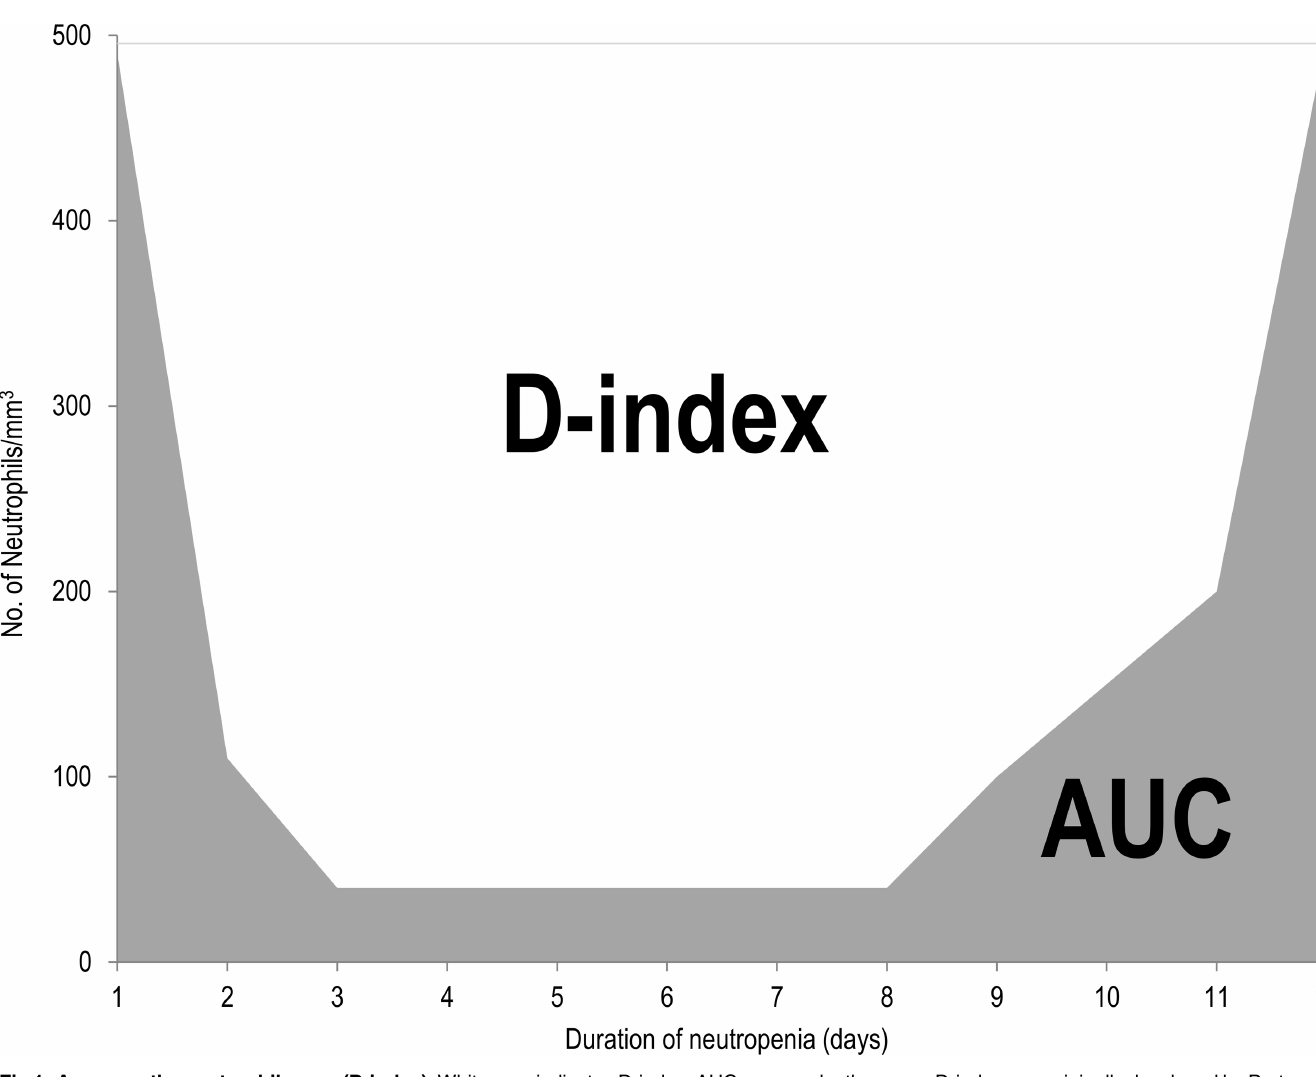
Fig 1. Areaover the neutrophil curve (D-index). White area indicatesD-index. AUC, area under the curve. D-indexwas originallydeveloped by Portugal et al [10].